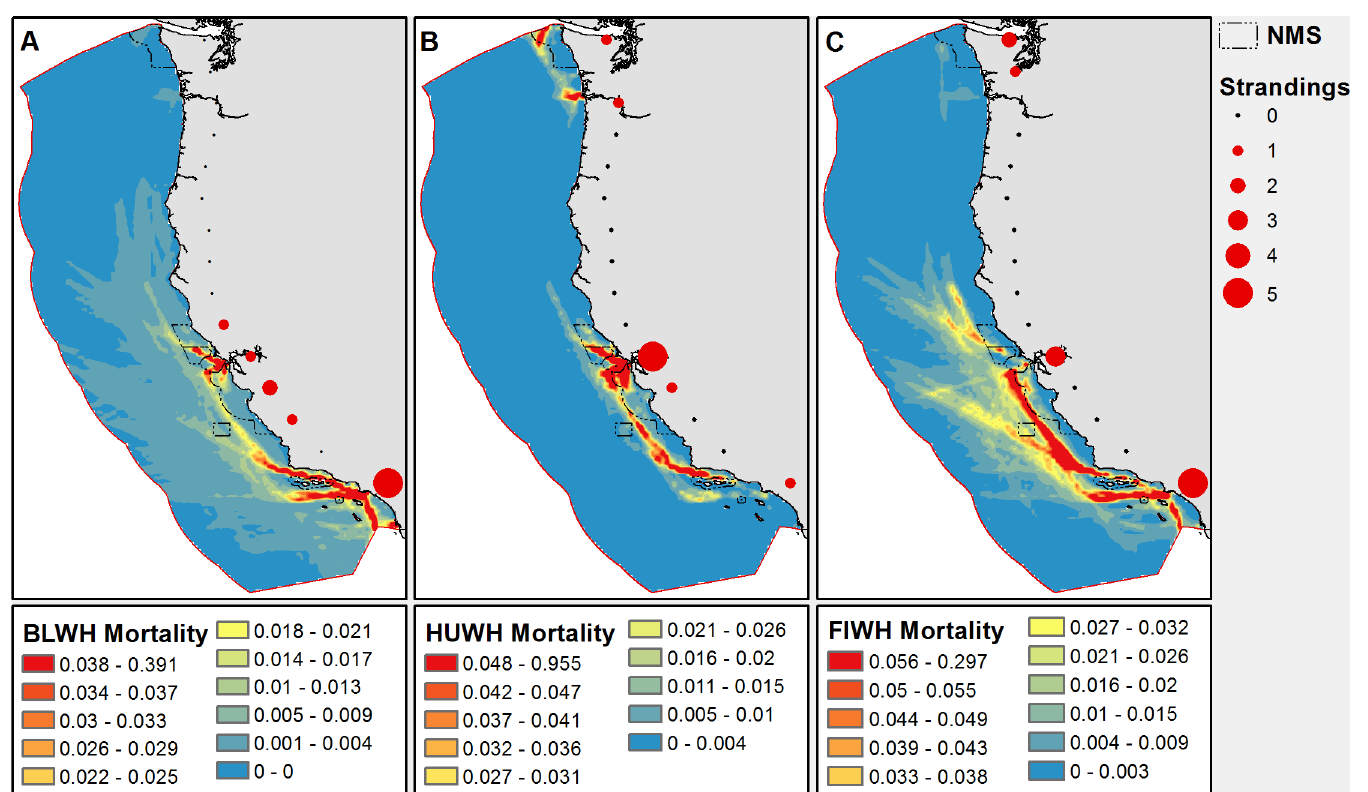
Fig 3. Smoothed distribution of blue (A), humpback (B), and fin whale (C) mortality estimated using Model 2. Warmer colors represent higher mortality and values are predicted mortalities per ~144 km 2 grid cell for the 6-month study period. Red circles represent latitudinallybinnedship strike strandingrecords from 2006–2016.Dashed lines are NationalMarineSanctuaryboundaries.